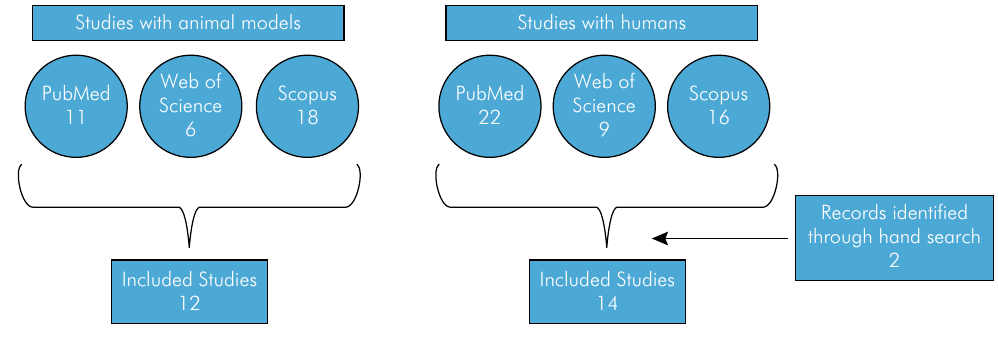
Figure 1. Flowchart of the review